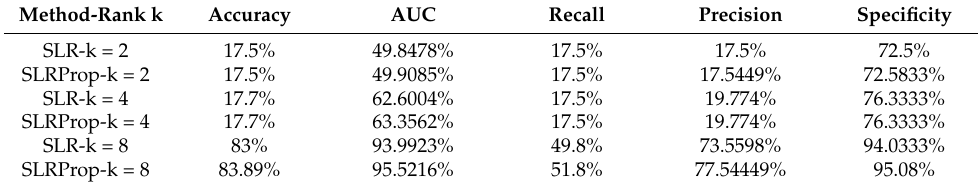
Table A4. SLR vs. SLRProp Room Occupancy